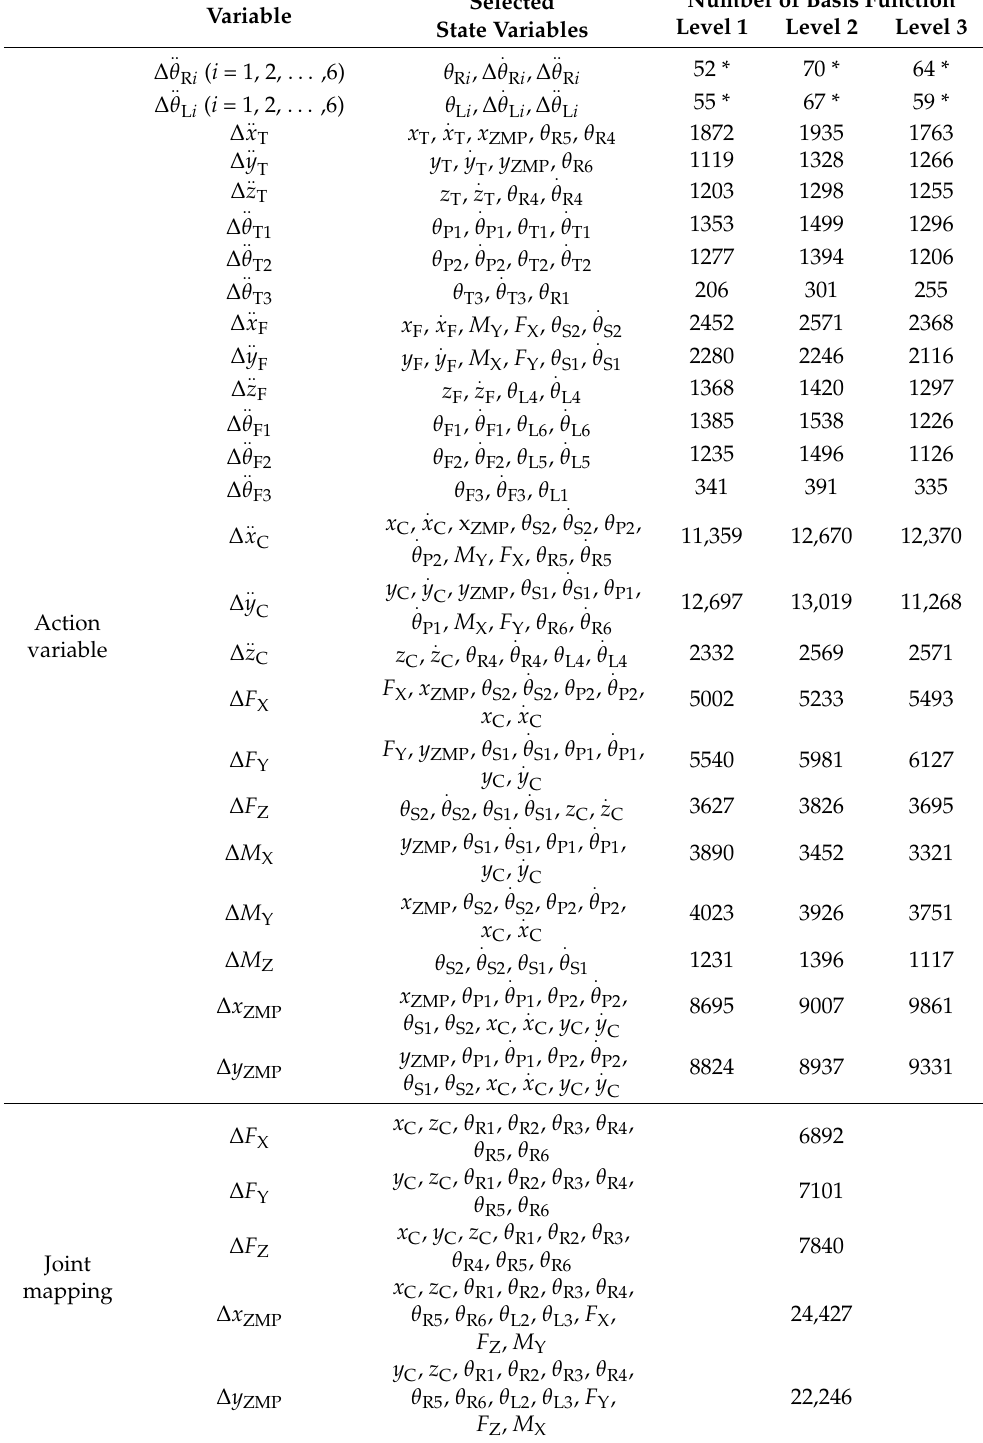
Table 7. Results of key feature selection and autonomic abstraction calculation of state